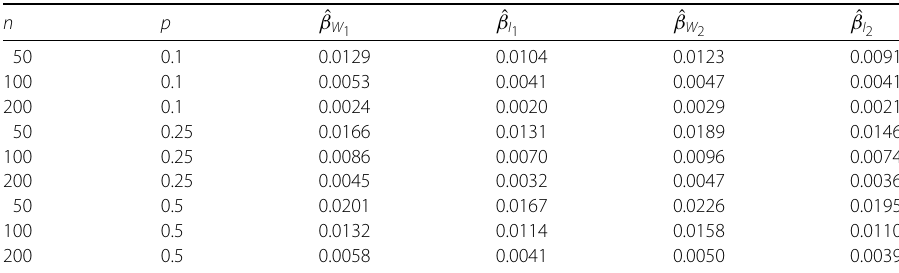
Table 1 The MSE for the estimators of β ˆ β ˆ β ˆ β n p ˆ β W I 1 W 2 I 2 1 50 0.1 0.0129 0.0104 0.0123 0.0091 100 0.1 0.0053 0.0041 0.0047 0.0041 200 0.1 0.0024 0.0020 0.0029 0.0021 50 0.25 0.0166 0.0131 0.0189 0.0146 100 0.25 0.0086